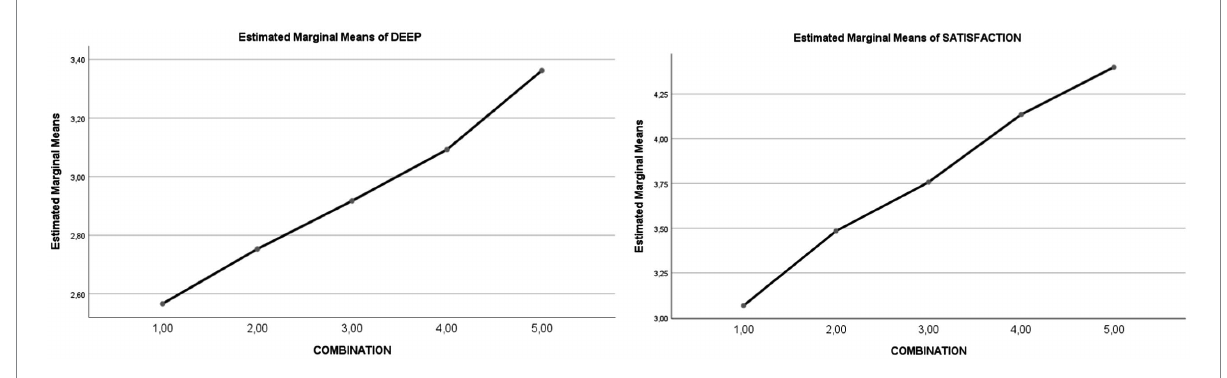
FIGURE 3 Effect of the SR-ER couple on the variables of deep learning and satisfaction in